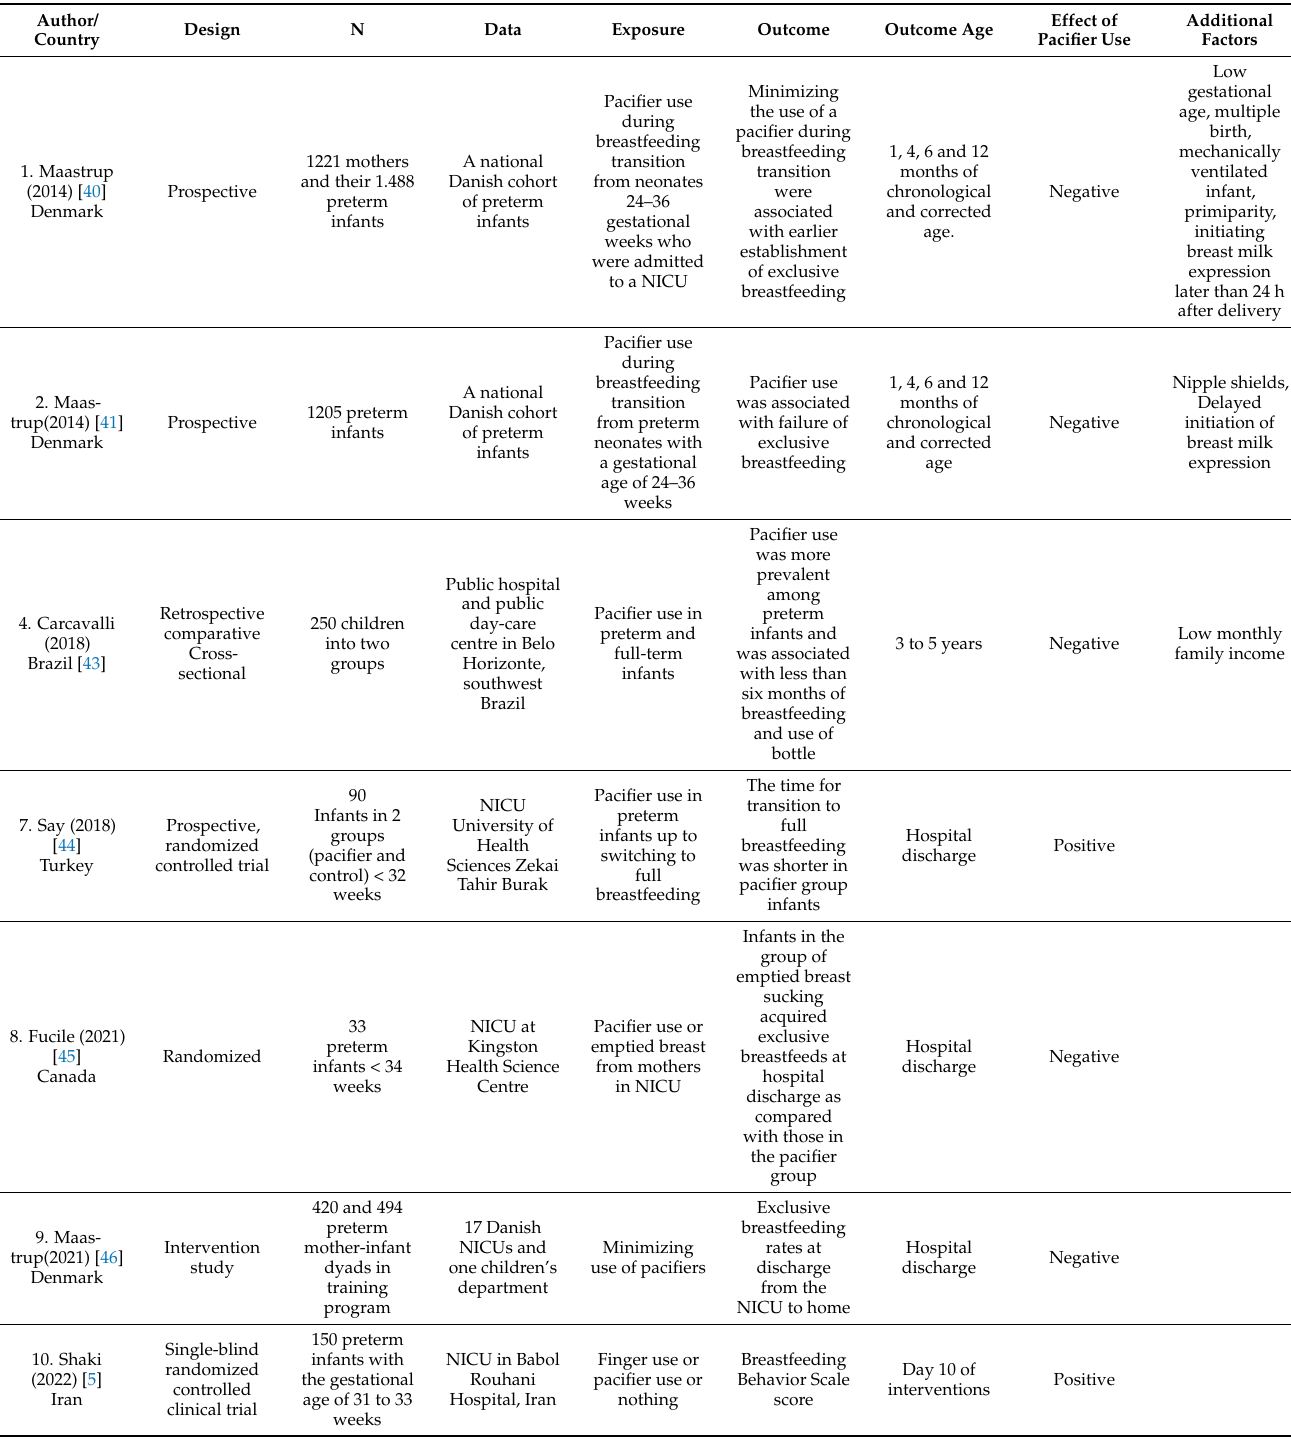
Table 2. The characteristics of the studies included in the systematic